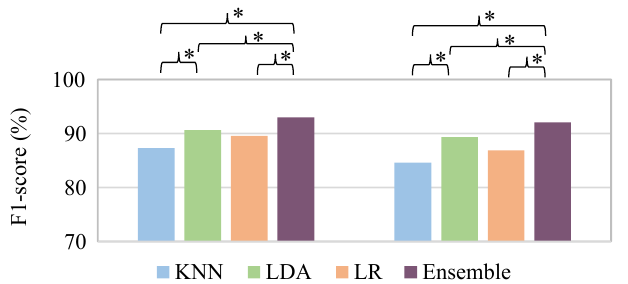
Figure 4. Nemenyi post-hoc test of F1-score between the different classifiers for both validation ( left ) and testing ( right ) dataset. ∗ means significant statistical difference ( p -value ≤ 0.05) between classifier performance.